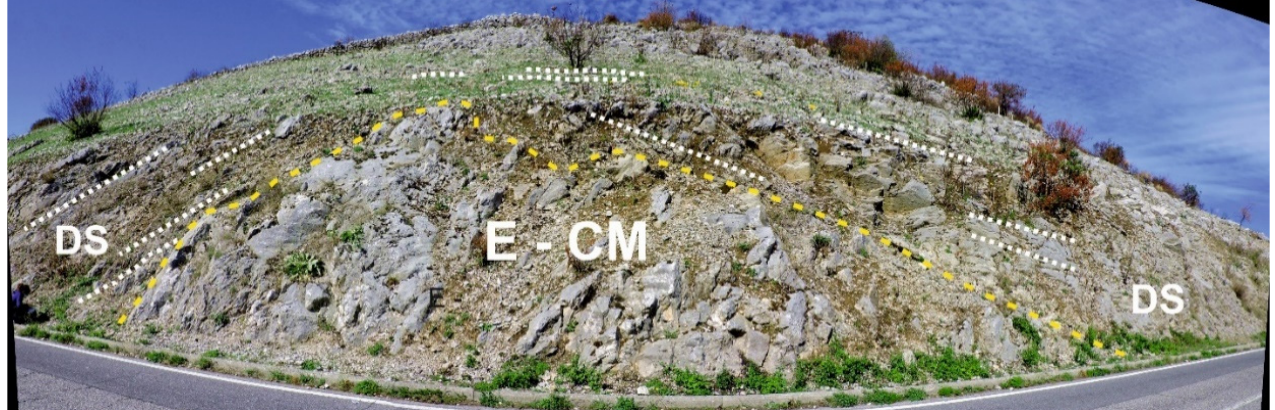
Figure 4. In the South Eastern Prenestini crudely stratified Eocene coral mounds (E-CM) overlie the Cretaceous substrate. These mounds are onlapped by planktonic and spiculitc wackestone of detritic Scaglia (DS).